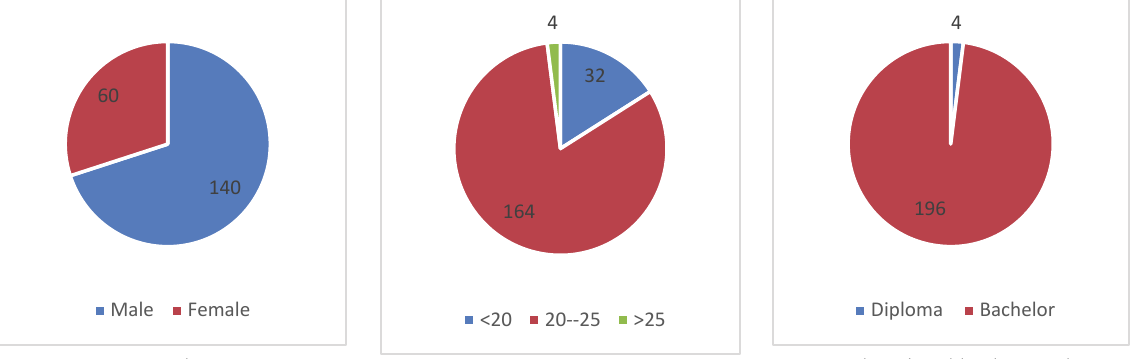
Fig. 1. Personal characteristics of the participants